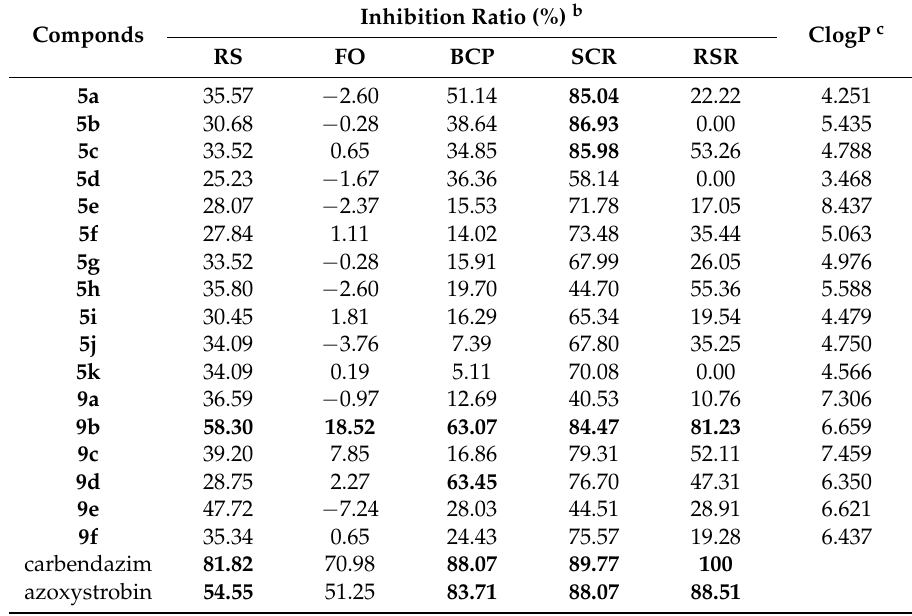
Table 2. Fungicidal activities of compounds 5a – k , 9a – f against four kinds of fungi (50 µ g/mL) a .